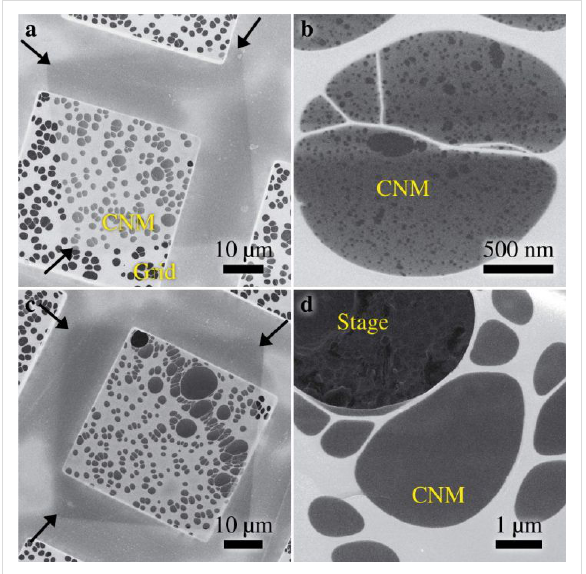
Figure 2: Freestanding CNMs with a dimension of 50 × 50 µm 2 supported by a TEM grid with a holey carbon film: (a) the HIM micro- graph of a CNM with an irradiation dose of 500 µC/cm 2 , where three arrows mark its corners; (b) the high magnification HIM micrograph shows that the CNM contains tiny holes; (c) the HIM image of a CNM with an irradiation dose of 1000 µC/cm 2 ; (d) the high magnification HIM image shows that the CNM contains no microscopic defects. (Imaging doses: a) 0.27 µC/cm 2 , b) 55.9 µC/cm 2 , c) 3.36 µC/cm 2 and d) 33.6 µC/cm 2